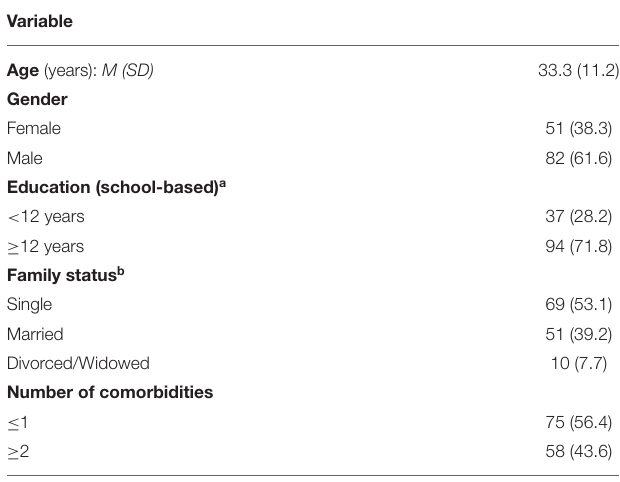
TABLE 1 | Sociodemographic characteristics of the analysis sample ( N = 133).